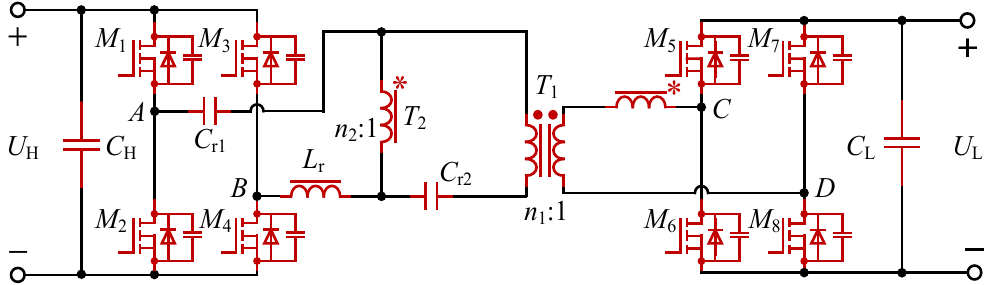
Figure 1. The proposed DHC-LT BDC (The symbols of “*” are dotted terminals of T 2